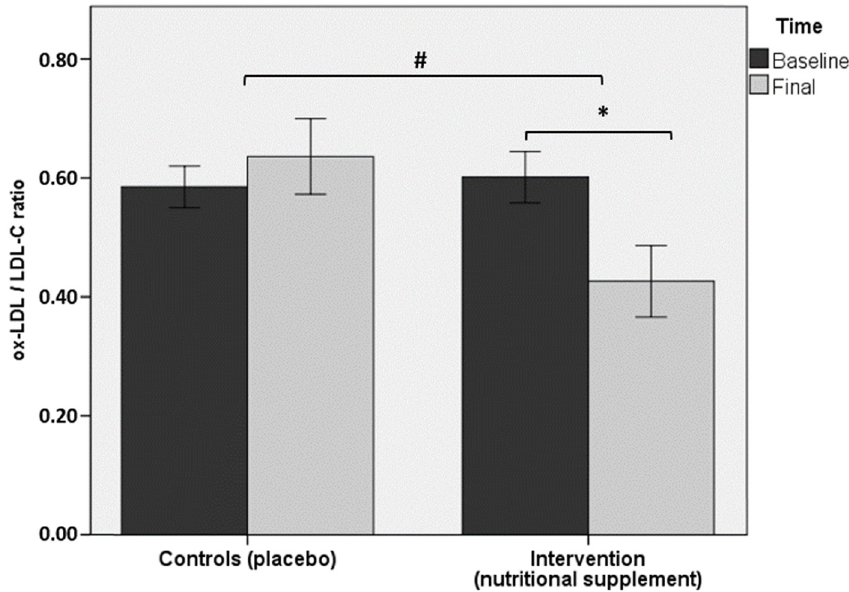
Figure 3. Between-group differences ( p < 0.05) in the intervention group in ox-LDL/LDL-C ratio at the end of the study (90 days) as compared with baseline (*asterisk); within-group differences were also significant ( p < 0.05) (# number sign).